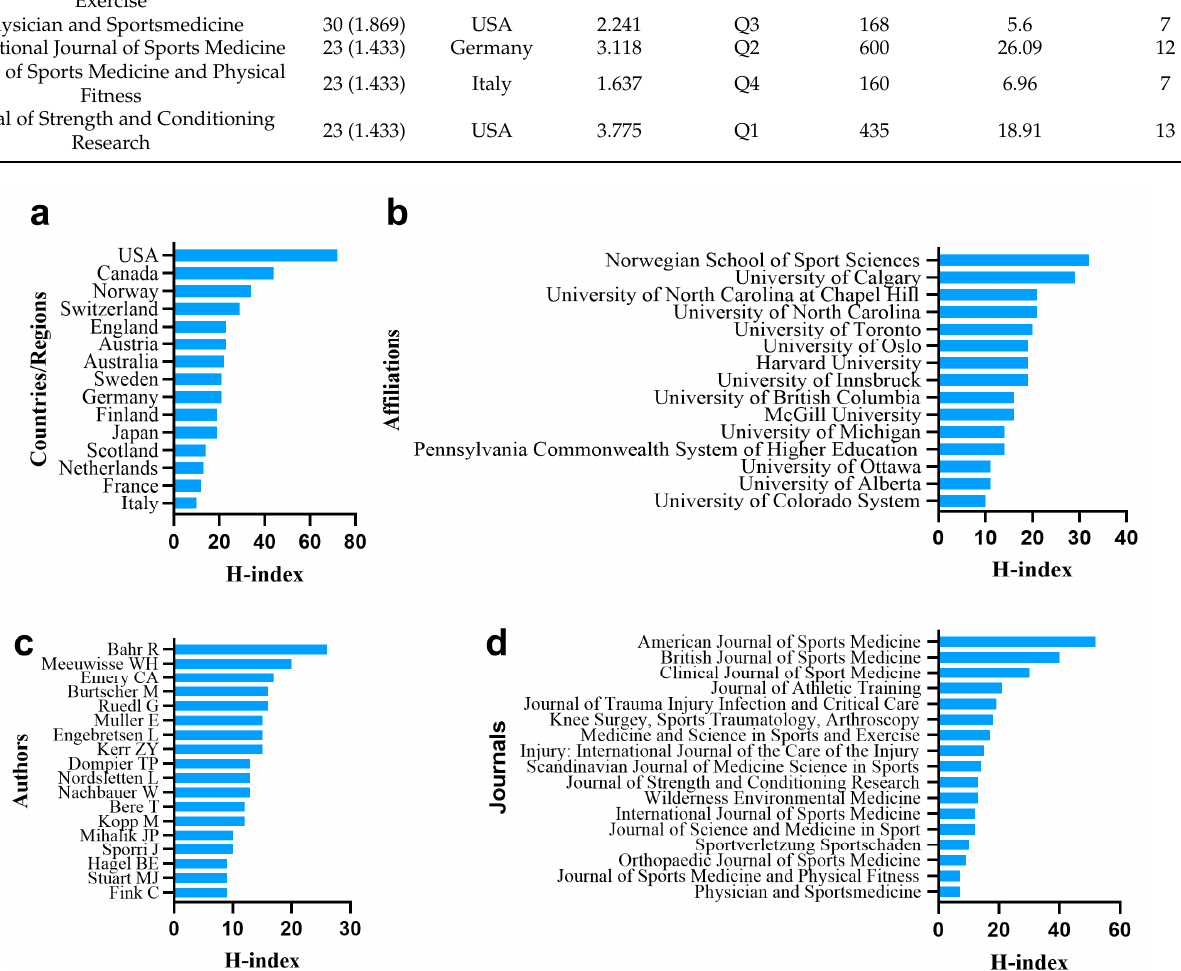
Figure 2. ( a – d ) The top 15 countries/regions, affiliations, authors and journals regarding H-index of publications. Table 1. The top 15 most published and cited active countries/regions in the top 3 research directions related to snow and ice sports injuries.